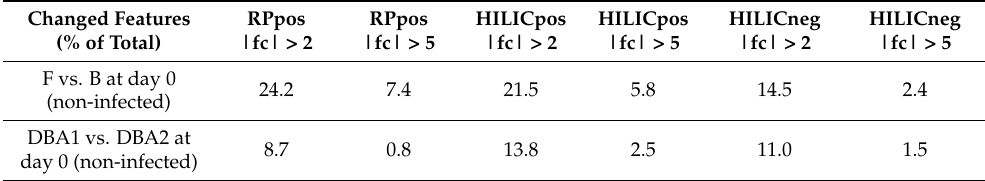
Table 1. Metabolic feature analysis performed in the three untargeted metabolomics platforms used for this study prior to LCMV infection (day 0). The percentage of changed features was calculated in respect to the total number of measured features for each analytical platform. |fc| > 2 represents features with a fold change between strains that was greater than 2 (or lower than 0.5). |fc| > 5 rep- resents features with a fold change between strains greater than 5 (or lower than 0.2). Only features with an intensity over 5000 counts were considered for the analysis. RPpos: reversed-phase positive ion mode; HILICpos: hydrophilic interaction liquid chromatography positive ion mode; HILICneg: hydrophilic interaction liquid chromatography negative ion